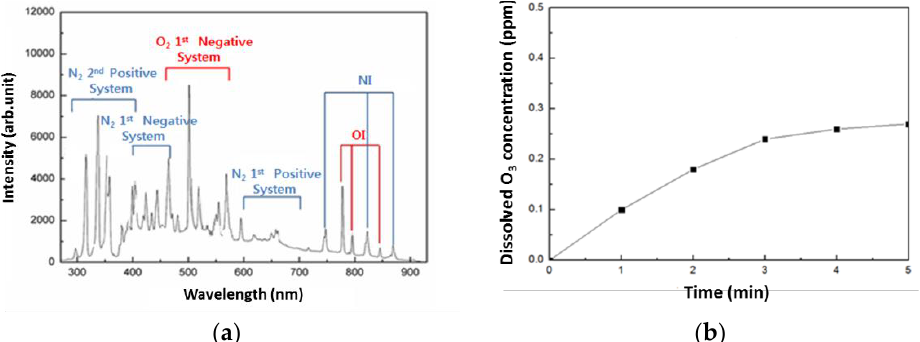
Figure 3. Reactive species generated in plasma jet and PAM. ( a ) Optical emission spectrum of air plasma jet. ( b ) Concentration of dissolved ozone in Dulbecco's Modified Eagle Medium (DMEM) vs. plasma treatment time.